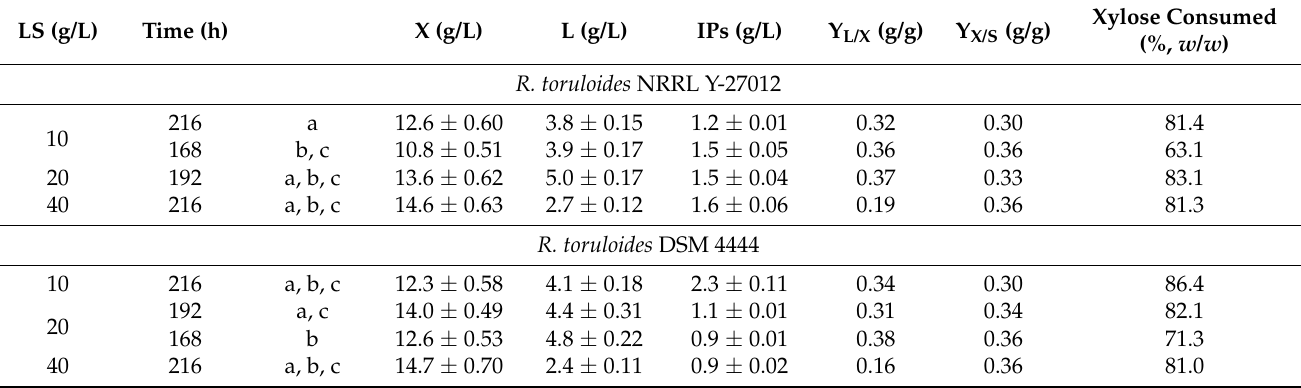
Table 2. Quantitative data of R. toruloides DSM 4444 and NRRL Y-27012 cultivated on commercial-type xylose (S), during batch experiments using various concentrations of lignosulphonates (0–40